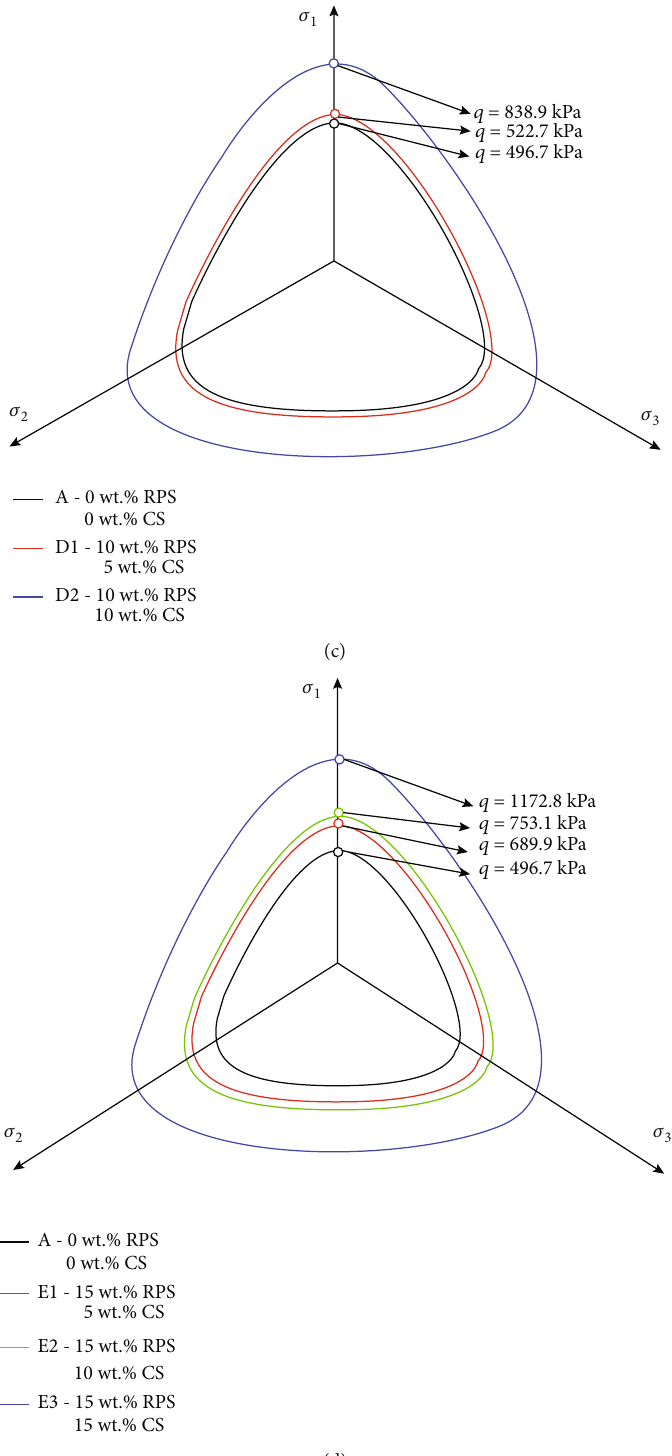
Figure 13: Yield curves of the modi fi ed soils under 200 kPa con fi ning pressure: (a) the red Pisha sandstone modi fi ed soils; (b) the carbide slag modi fi ed soils; and (c, d) the red Pisha sandstone and carbide slag modi fi ed